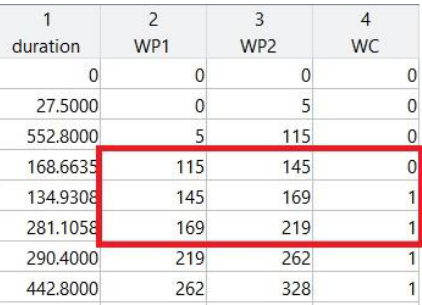
Figure A2. Solution of the coverage of path category and duration (own illustration) .